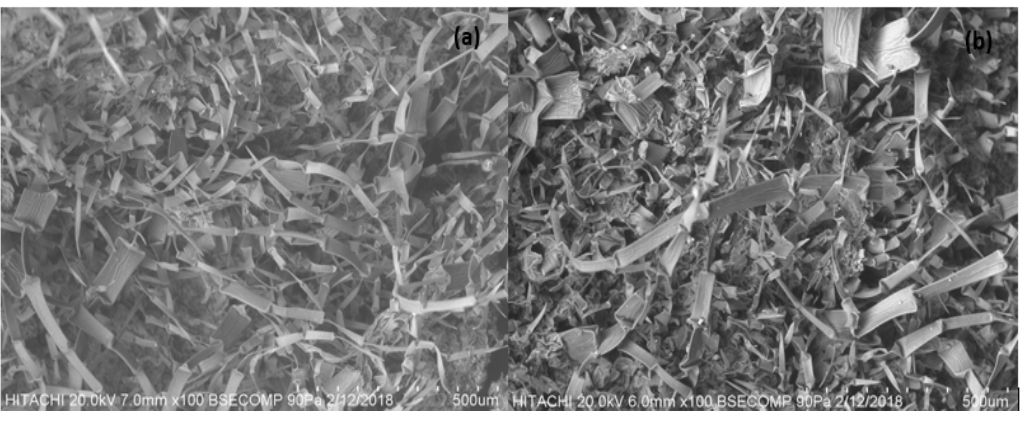
Processes 2020, 8, 322 14 of 17 Figure 7. SEM image of leaves after UAE: (a) at 20 min; (b) at 40 min. Figure 7. SEM image of leaves after UAE: ( a ) at 20 min; ( b ) at 40 min.